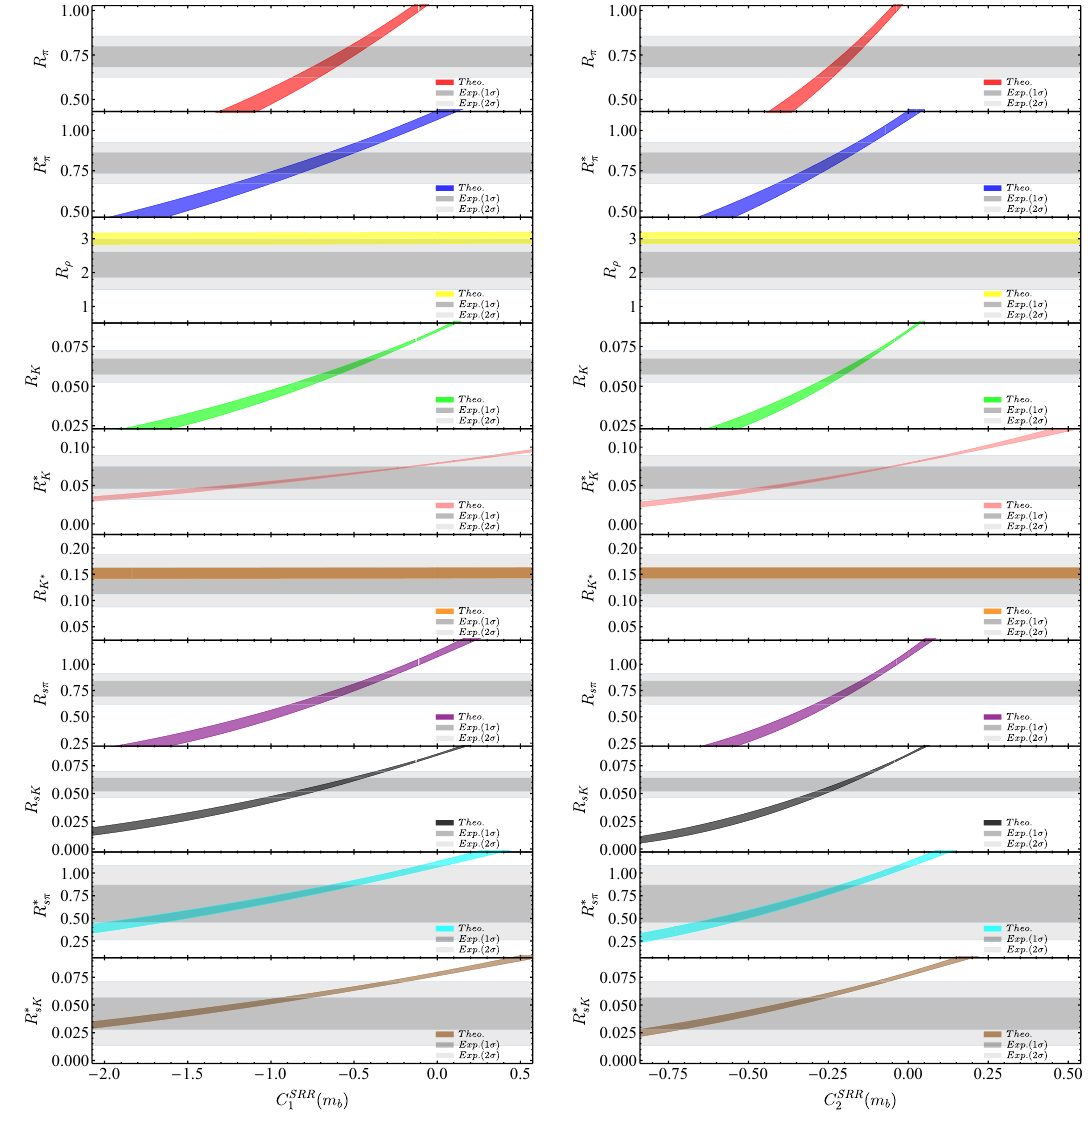
Figure 7 . Same as in figure 5 but for the NP Wilson coefficients C SRR